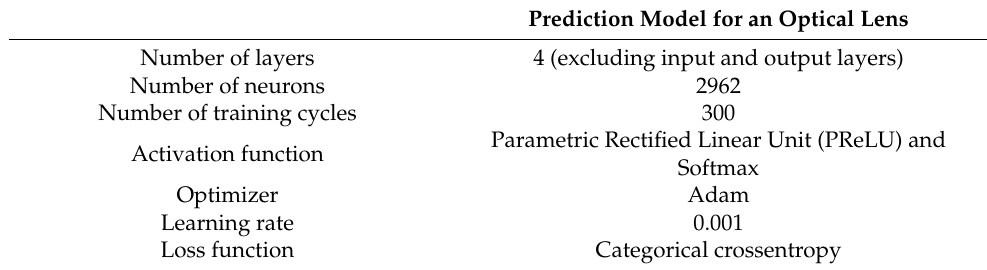
Table 5. Details of the neural network model used in this